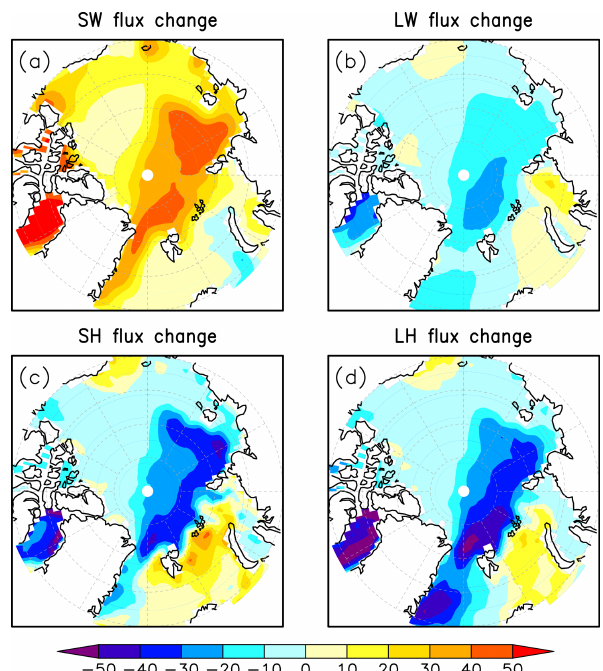
Figure 3. Spatial distributions of the Pliocene annual mean heat flux change (Wm − 2 , positive downward) with respect to the pre- industrial period over the Arctic Ocean. (a) Net shortwave flux (SW), (b) net longwave radiation flux (LW), (c) sensible heat flux (SH) and (d) latent heat flux (LH).